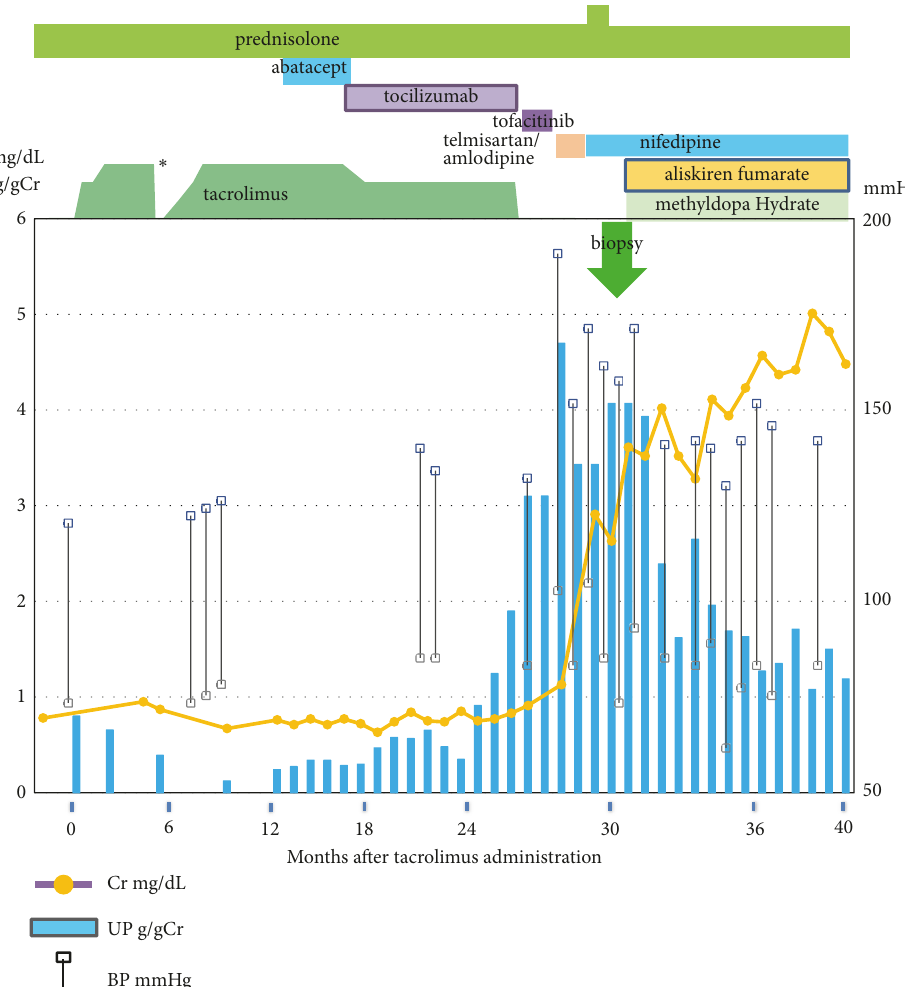
Figure 1: Clinical course of the patient after introduction of tacrolimus treatment. ∗ : surgical operation, Cr; creatinine, UP; proteinuria, and BP; blood